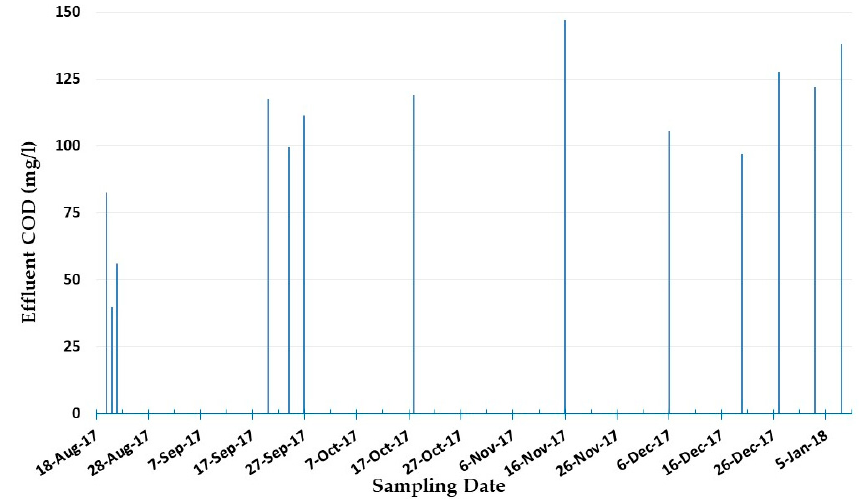
Figure 5. Effluent chemical oxygen demand (COD) results of samples collected from 20 August 2017 to 8 January 2018.